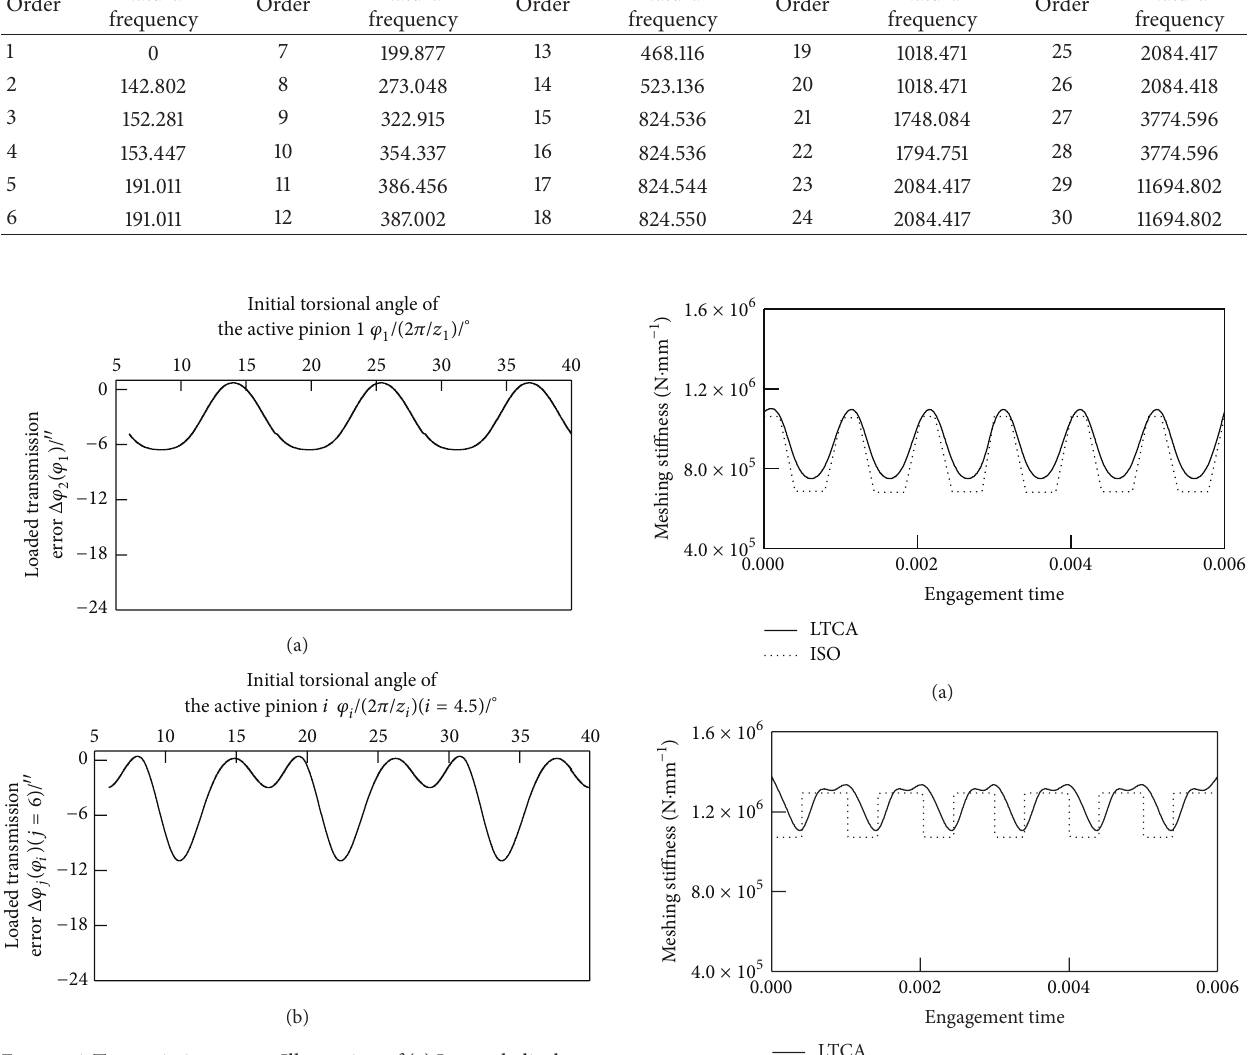
Figure 6: Transmission errors. Illustration of (a) I-stage helical gear pairs and (b) II-stage spur gear pairs.